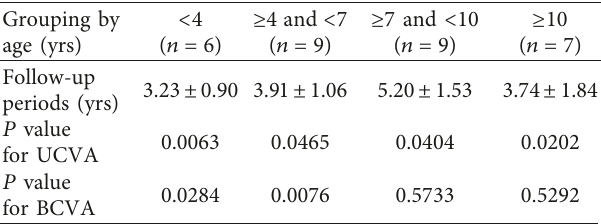
Table 2: Comparison of visual acuity (UCVA and BCVA sepa- rately) of children at different ages between the first and last